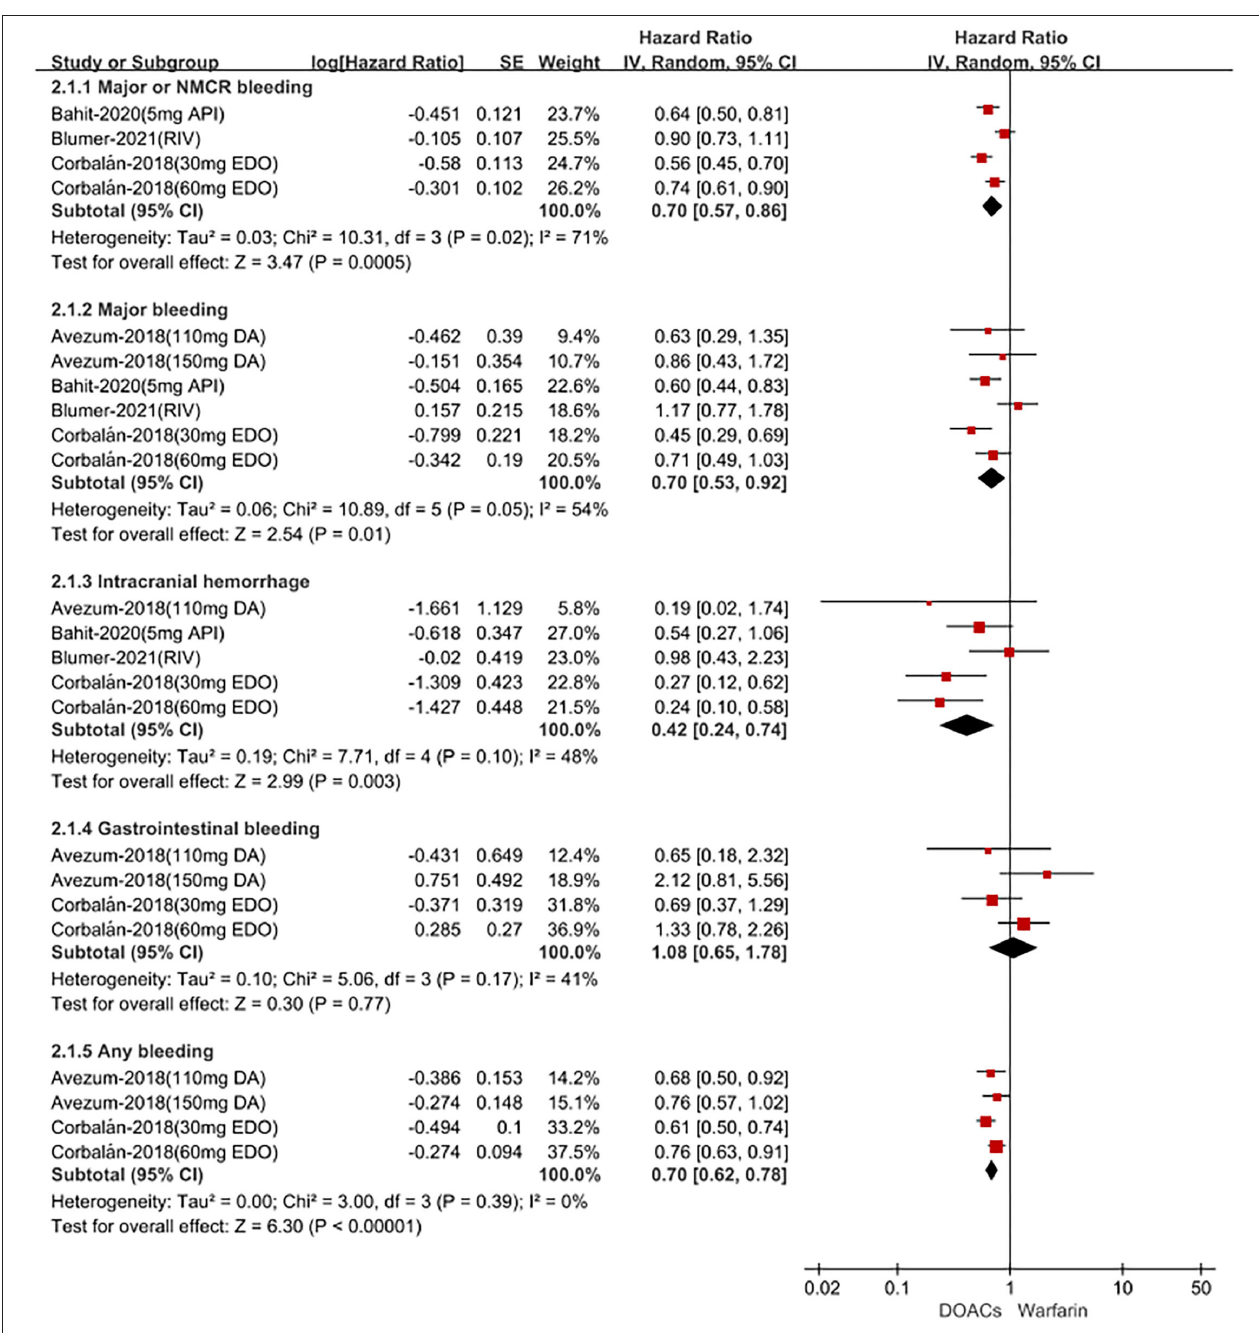
FIGURE 2 | Adjusted safety date of direct oral anticoagulants compared with warfarin in Latin patients with atrial fibrillation. DOACs, direct oral anticoagulants; DA, dabigatran; API, apixaban; EDO, edoxaban; RIV, rivaroxaban; CI, confidence interval.